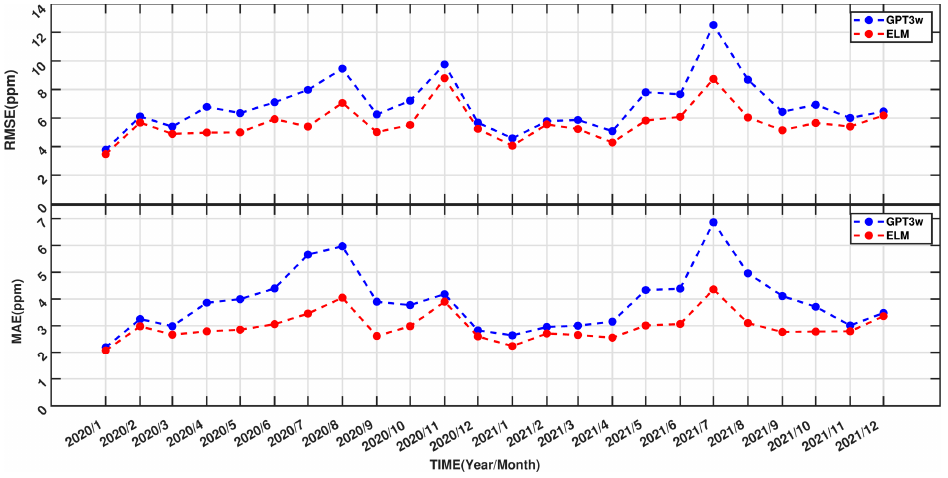
Figure 10. The monthly RMSE and MAE values for the comparison of the ELM and GPT3w wet refractivity indices with the corresponding RO observations.